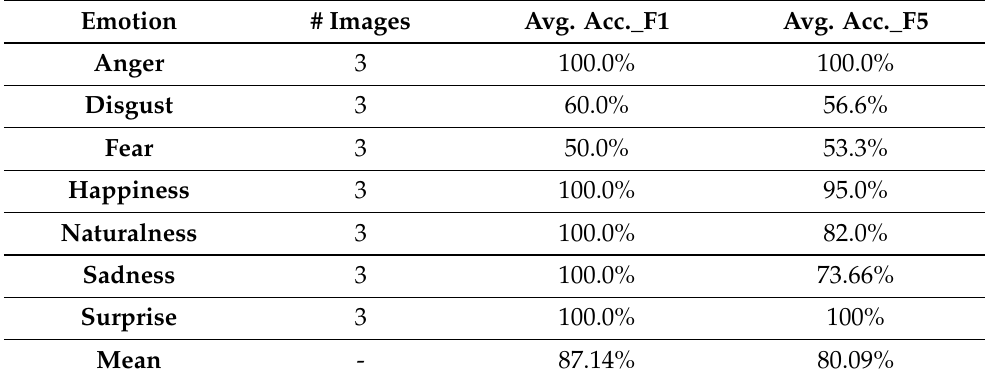
Table 2. Performance per class and average accuracy using both models, achieved with one-fold and five-fold cross-validation, on test set from JAFFE dataset.